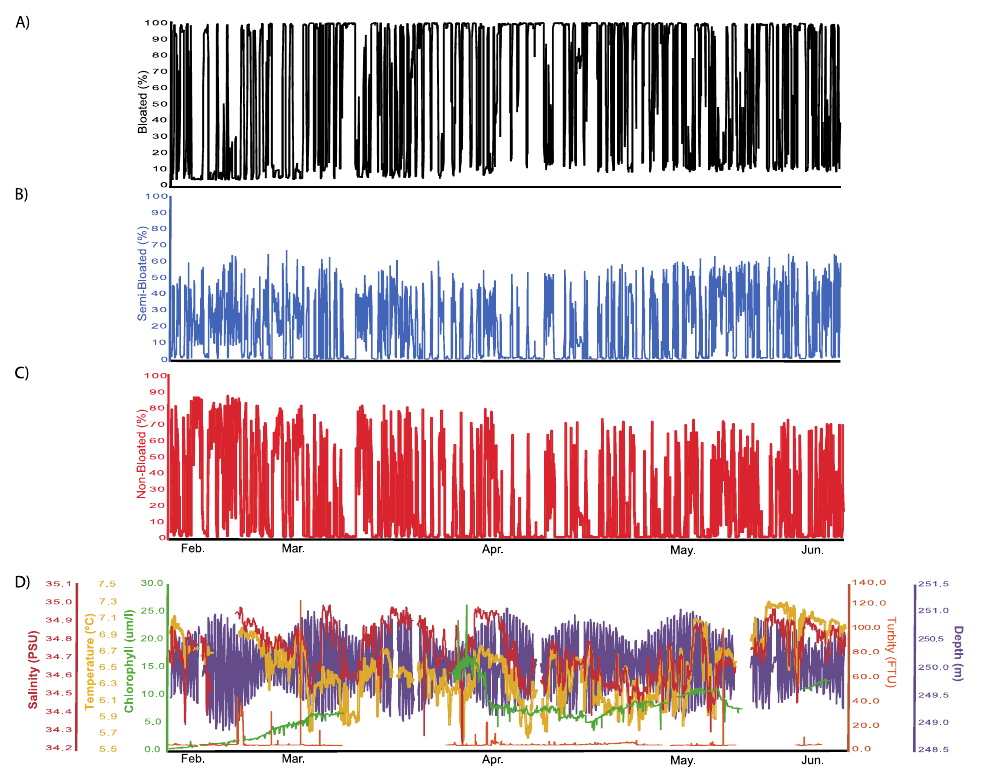
Figure 9. Time series of automated percentages of colony surface with polyps in full extrusion (bloated; ( A )) or full retraction (non-bloated; ( C )) status as well as the intermediate condition with patches of both (semi-bloated; ( B )), plus the concomitantly monitored oceanographic variables for comparison ( D ). Table 3. Time series parameters as absolute maximum and minimum as well as significant ( p > 0.05) periods (both in total minutes (Min) and hours (h)) for all behavioral and oceanographic variables measured at the LoVe observatory in 2018. The Midline Estimated Statistic of a Rhythm (MESOR) is also reported as a result from waveform analysis for all the time